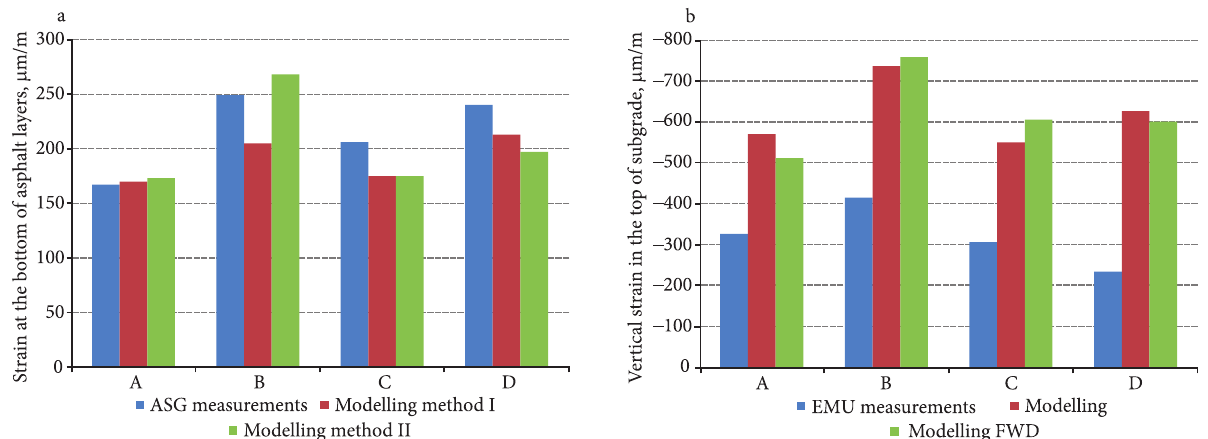
Fig. 10. Comparison of measured and calculated strains: a – horizontal strains at the bottom of asphalt layers ( ε ye ); b – vertical strains at the top of subgrade ( ε ze